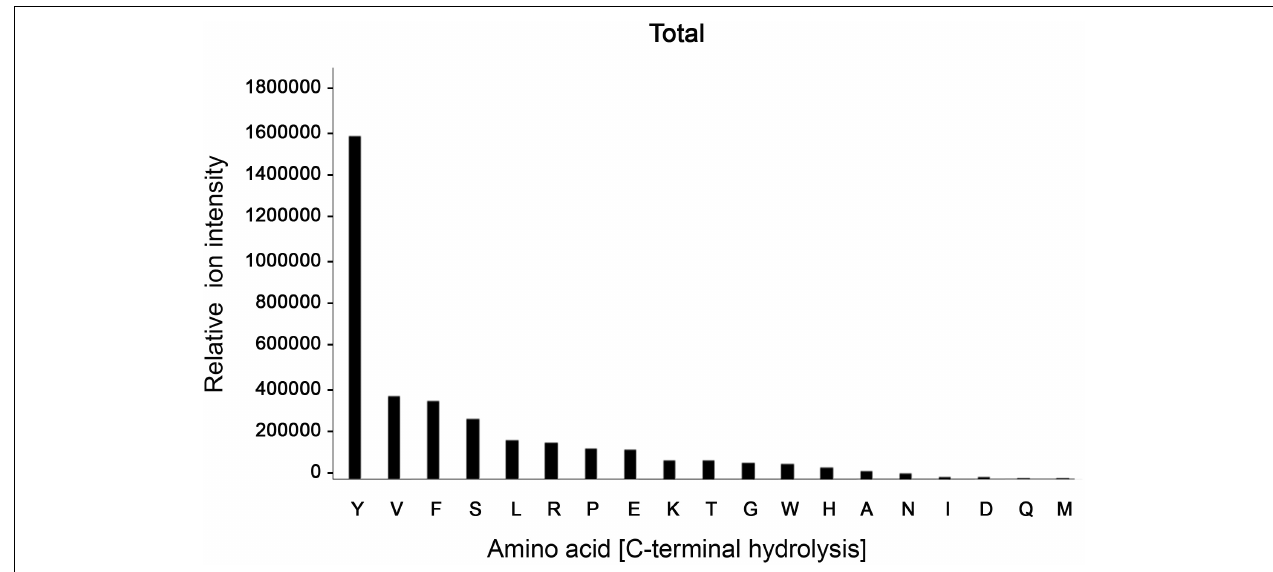
FIGURE 6 | BspE displays broad activity on shorter peptides and denatured proteins. The combined results following screening of BspE activity on several peptides (MOG, and myoglobulin, H2686, and glycodrosocin). Enzymatic cleavage sites were mapped, and preference of amino acids calculated. The cleavage profile for the individual peptides can be found as ( Supplementary Figure S2 ) and sequences as ( Supplementary Table S1 ). The x-axis shows hydrolysis c-terminally of denoted amino acid. The y-axis denotes ion intensity measured.